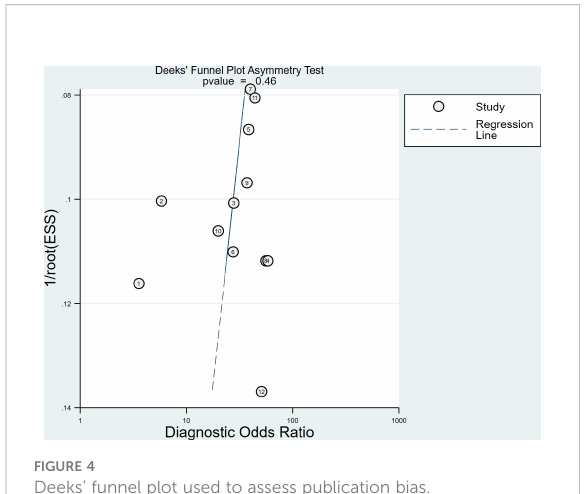
FIGURE 4 Deeks ’ funnel plot used to assess publication